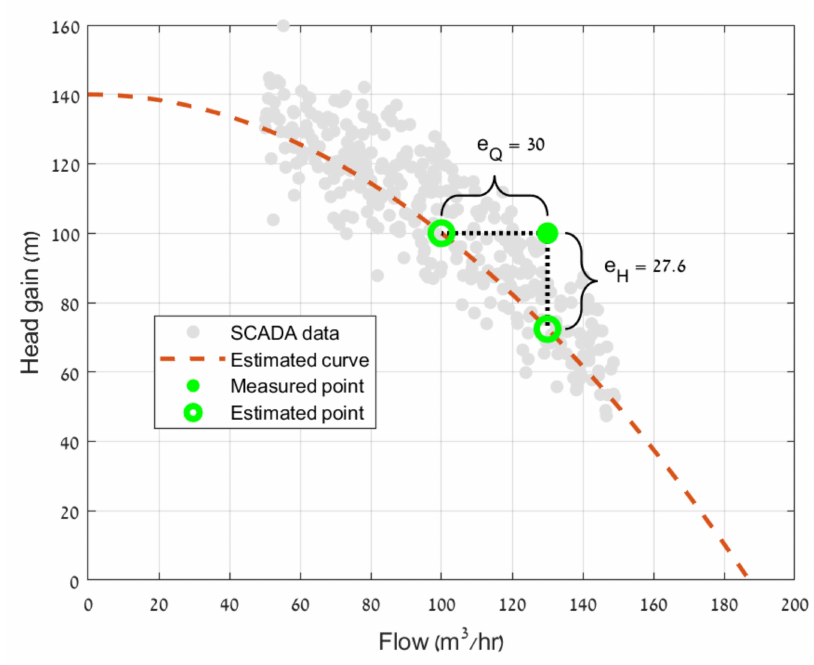
Figure 1. Vertical and horizontal errors between observations and assumed